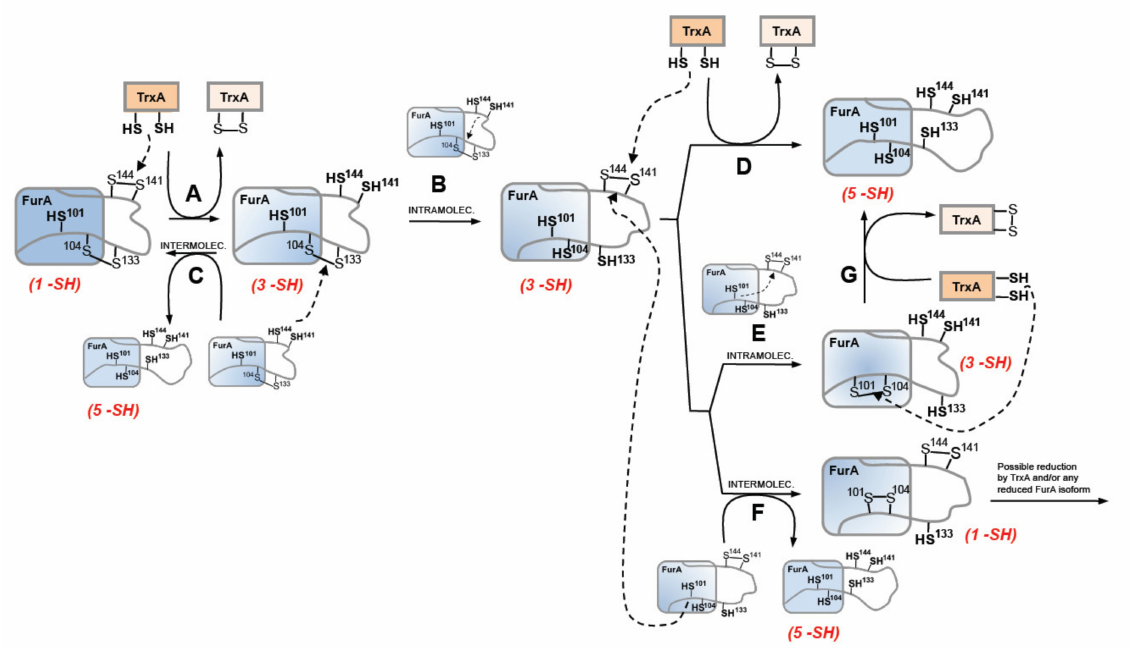
Figure 6. Proposed TrxA-mediated reduction mechanism of FurA from Anabaena sp. PCC7120. Arrowed dashed lines reflect the electron movement of the dithiol to the disulfide in each redox reaction, whereas arrowed solid lines denote the sequence in obtaining FurA isoforms in different oxidation states. Capital letters (A–G) identify the different redox processes involving FurA and TrxA that are explained in detail in the